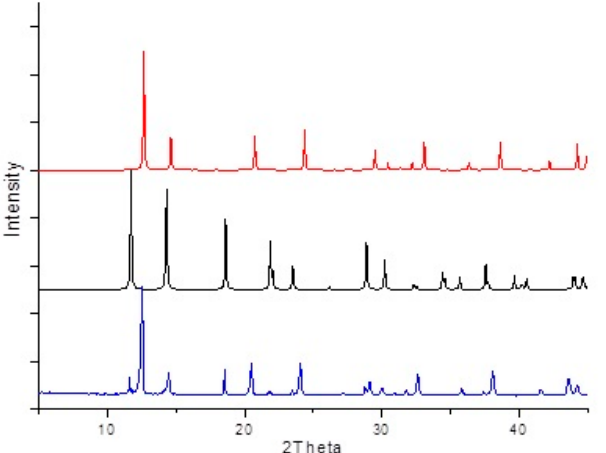
Figure 4. Experimental PXRD pattern of sample 2 after 1 h (blue) and calculated patterns of 2 (black) and “dichlorine-free” (Me 3 NH) 2 [PbCl 6 ] (red).